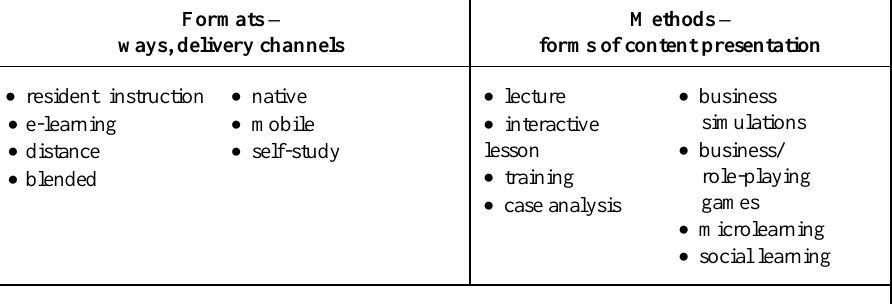
Table 1. Modern educational technologies